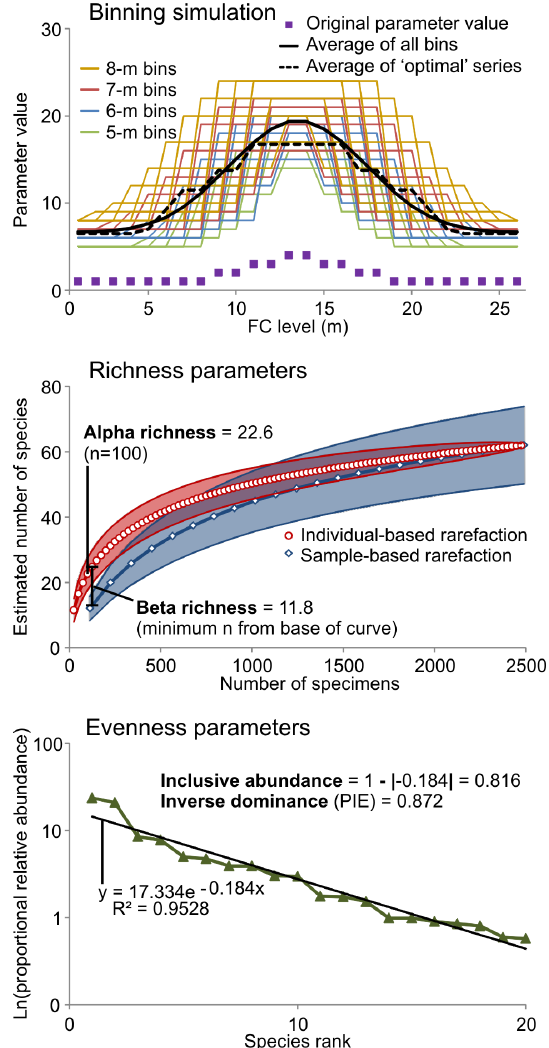
Figure 3. Illustration of the methods. The binning simulation il- lustrates a series of all possible bins at 5, 6, 7 and 8m thickness (thin lines) created for a hypothetical parameter distribution (purple squares) with a 10m peak. Parameter values are assigned to all me- ter levels within each bin and averaged by meter level across all bins (solid black line). Because calculation of parameters for all possi- ble binning series is prohibitive, this project uses the average of the optimal binning series (least number of gaps and maximum sample sizes) at each thickness (dashed black line). The richness and even- ness parameters are calculated from a representative binned sample (407–413m). Alpha richness is the individual-based rarefaction es- timate of the number of species in a sample of 100 specimens. Beta richness is the difference between the individual- and sample-based rarefaction curves at the base of the sample-based rarefaction curve. Inclusive abundance is the reciprocal of the absolute value of the slope of the exponential trend line of the rank–abundance curve. In- verse dominance is the probability of interspecific encounter